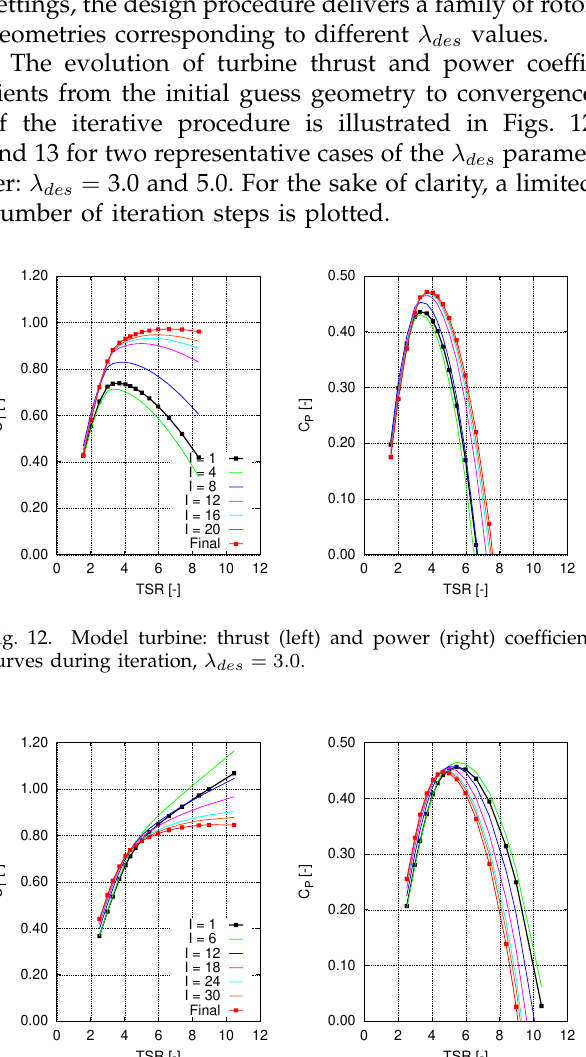
0.00 Fig. 13. Model turbine: thrust (left) and power (right) coefficient curves during iteration, λ des = 5 . 0 . Comparing the two cases reveals a different con- vergence behaviour. Specifically, in the λ des = 3 . 0